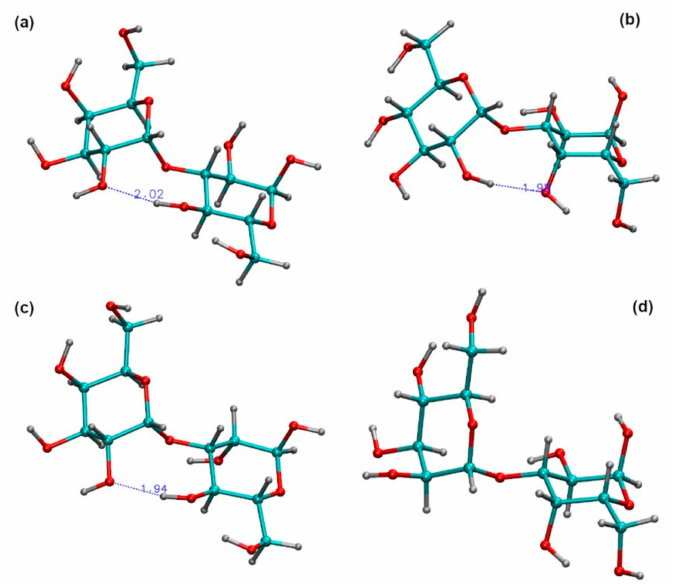
Figure 6. The global minimum energy structures for ( a ) the α -D-Gal p -(1 → 3)- α -D-Glc p disaccharide linkage, indicating the hydrogen bond between O2 of galactose and OH4 of glucose; ( b ) the α -D-Glc p -(1 → 3)- α -D-Gal p disaccharide linkage, indicating the hydrogen bond between OH2 of glucose and O4 of galactose; ( c ) the α -D-Gal p -(1 → 3)- α -D-Man p disaccharide linkage, indicating the hydrogen bond between O2 of galactose and OH4 of mannose; ( d ) the α -D-Man p -(1 → 3)- α -D-Gal p disaccharide linkage where no hydrogen bond can be